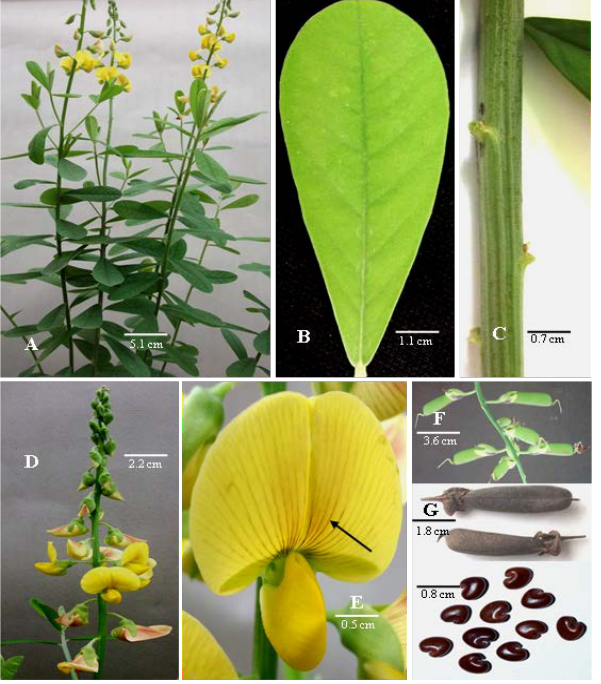
Fig. 8. Morphology of Vigna unguiculata (Linn.) Walp. A. Habit (herbaceous creeper or climber), B. Leaf, C. Stem, D. Fruit (fresh), E. Flower, F. Fruits (dry), G. Seeds, H. Inflorescence (axillary